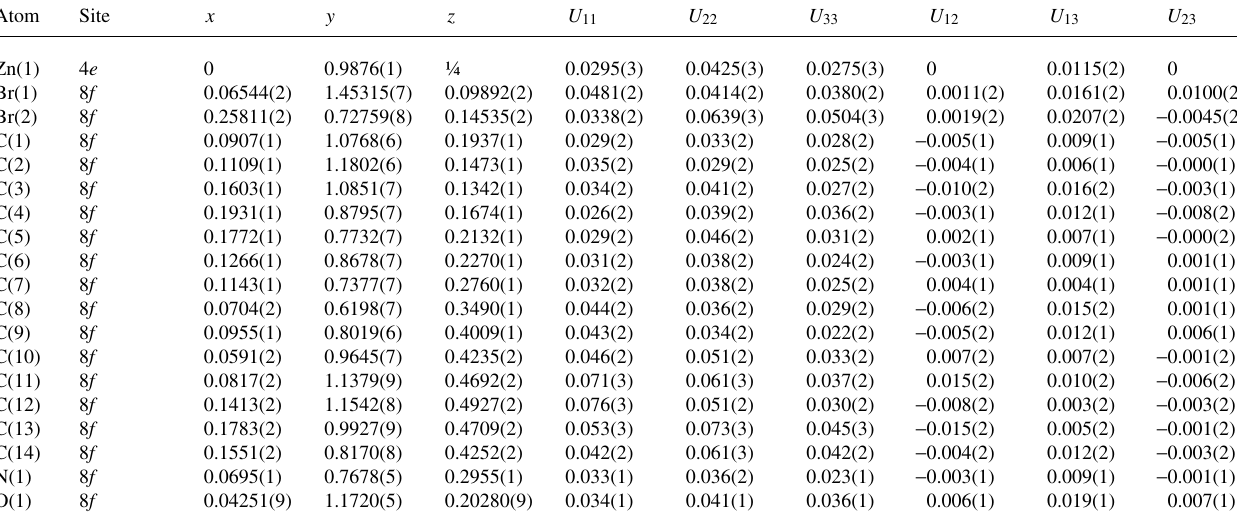
Table 3. Atomic coordinates and displacement parameters (in Å 2 )